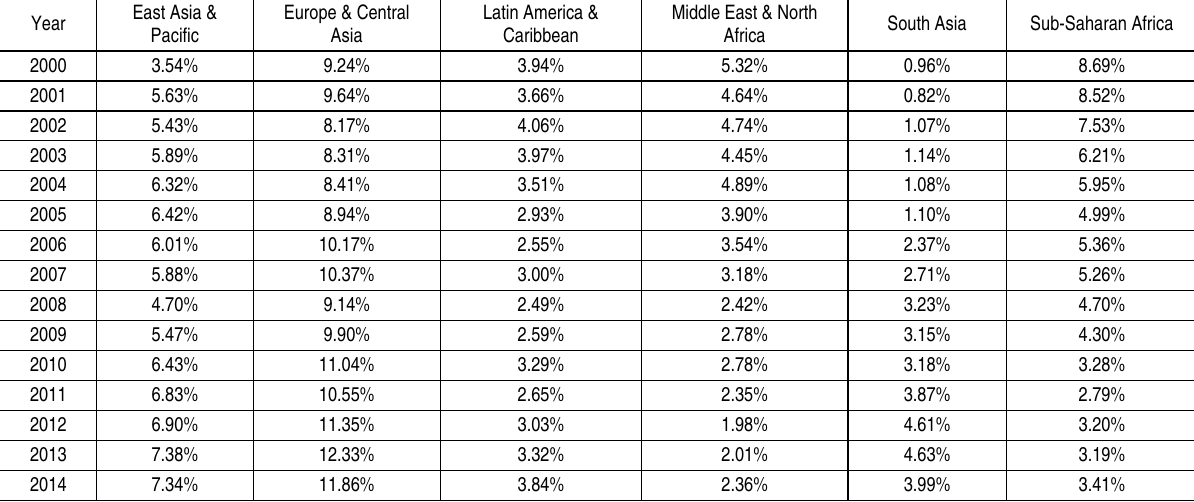
Table 8 (cont.). Trends in ST external debt to GDP region-wise